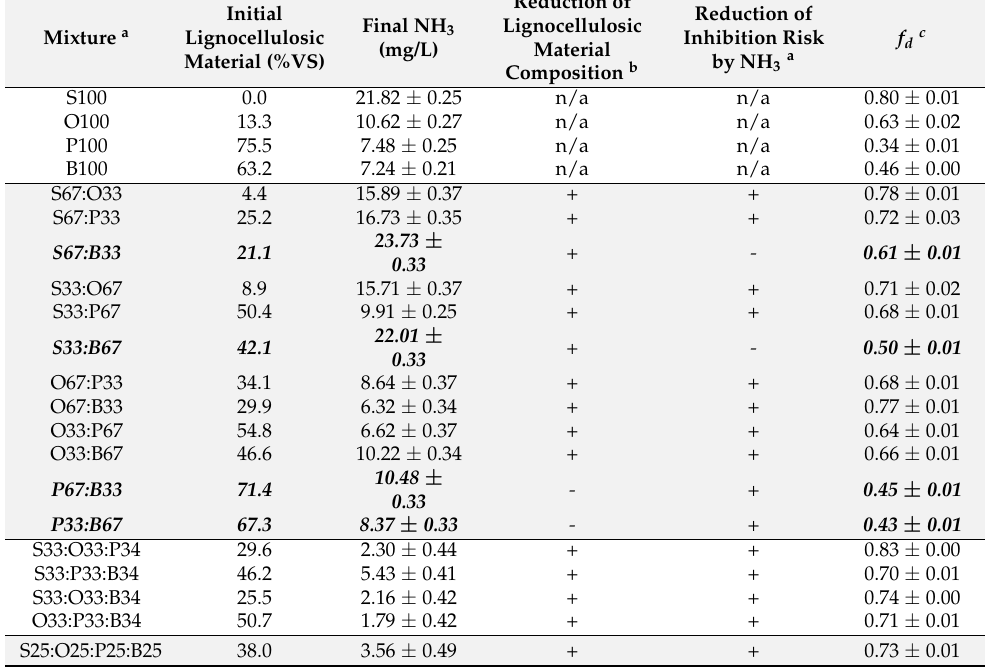
a The letter represents the waste stream (S: slaughter wastewater; O: offal wastewater; P: paunch wastewater; B: bovine manure) and the number its %VS in the mixture. b Positive and negative effects are indicated by + and − signs, respectively. Mixtures in bold and italic resulted in either high lignocellulosic content or ammonia inhibition. c f d : the extent of